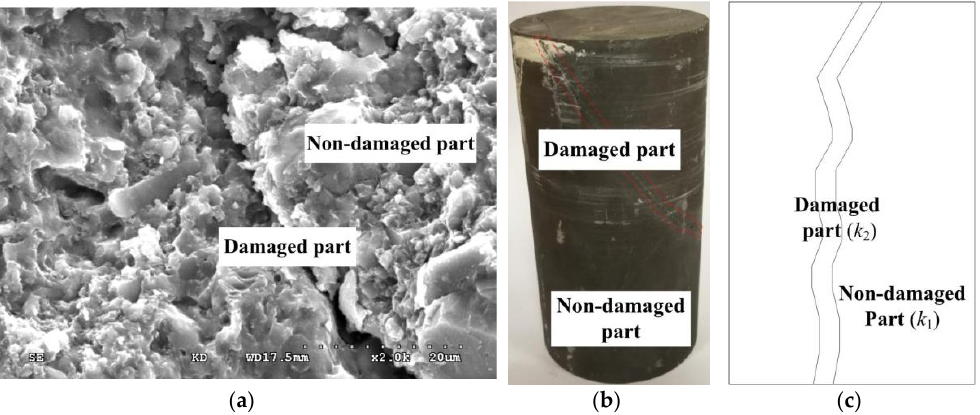
Figure 7. Simplified calculation model of k . ( a ) microscopic fracture surface; ( b ) macroscopic fracture surface; ( c ) RVE